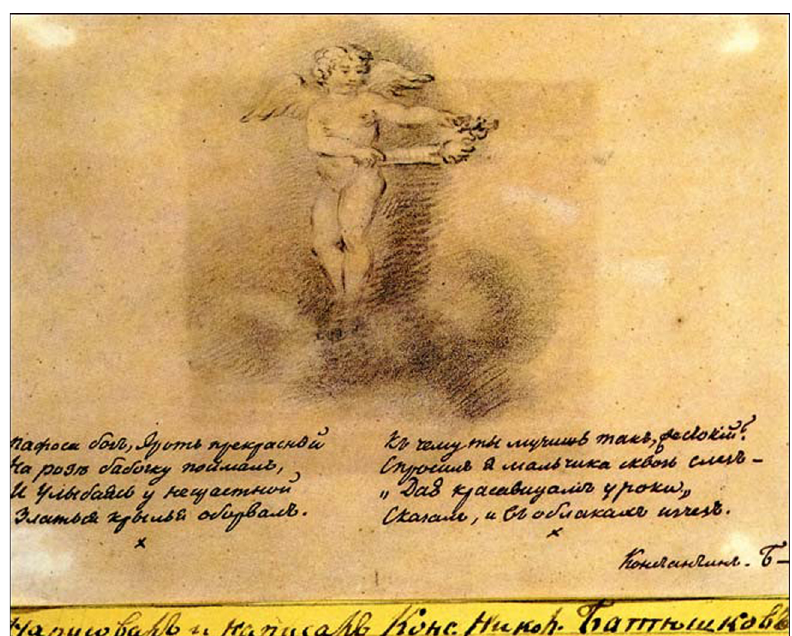
Figure 34. Konstantin Batiushkov. “The God of Paphos, beautiful Eros . . . ”, 1809. National Library of Russia, Saint